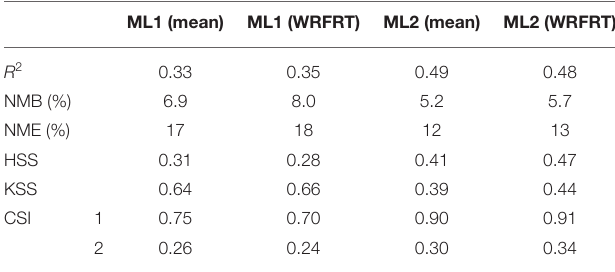
TABLE 6 | Statistics and forecast verifications in